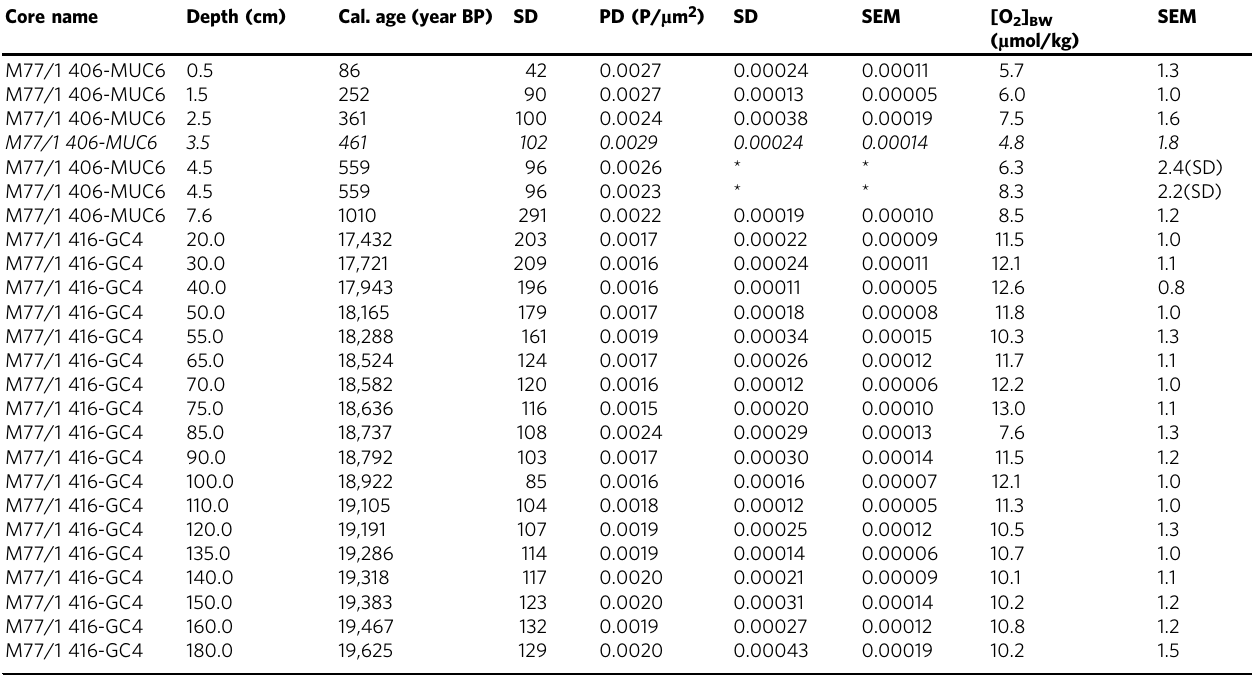
Table 4 Mean pore densities (PD) of P. limbata , calibrated ages (Cal. age) from the age model and reconstructed bottom water O 2 concentrations ([O 2 ] BW ) for the downcore reconstructions in cores M77/1 406-MUC6 and M77/1 416-GC4.